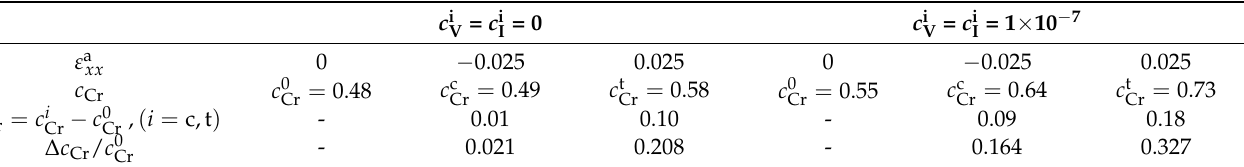
Table 1. The concentration changes of Cr at 750 K under the effects of compressive and tensile strains. c i = c i = V I